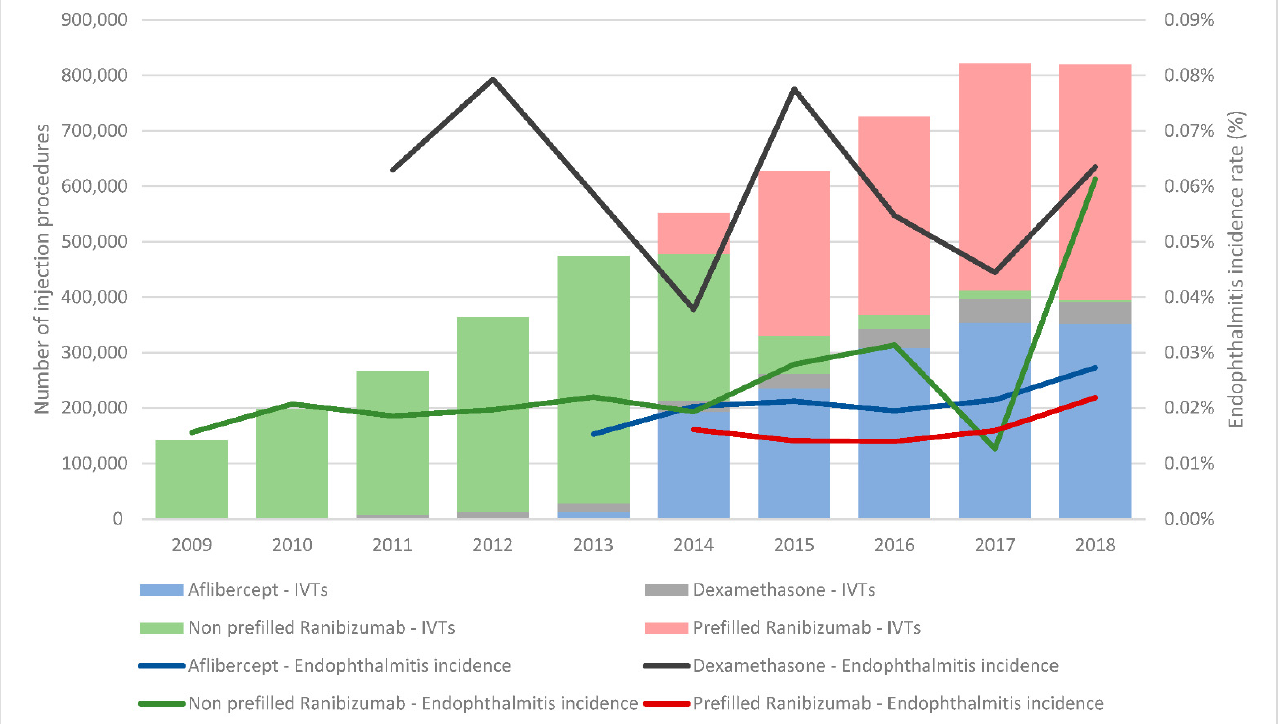
Figure 1. Proportion of IVT treatments and their relative endophthalmitis incidence rates. Due to the low proportion of IVTs with triamcinolone, pegaptanib, and bevacizumab, they are not displayed in this figure.